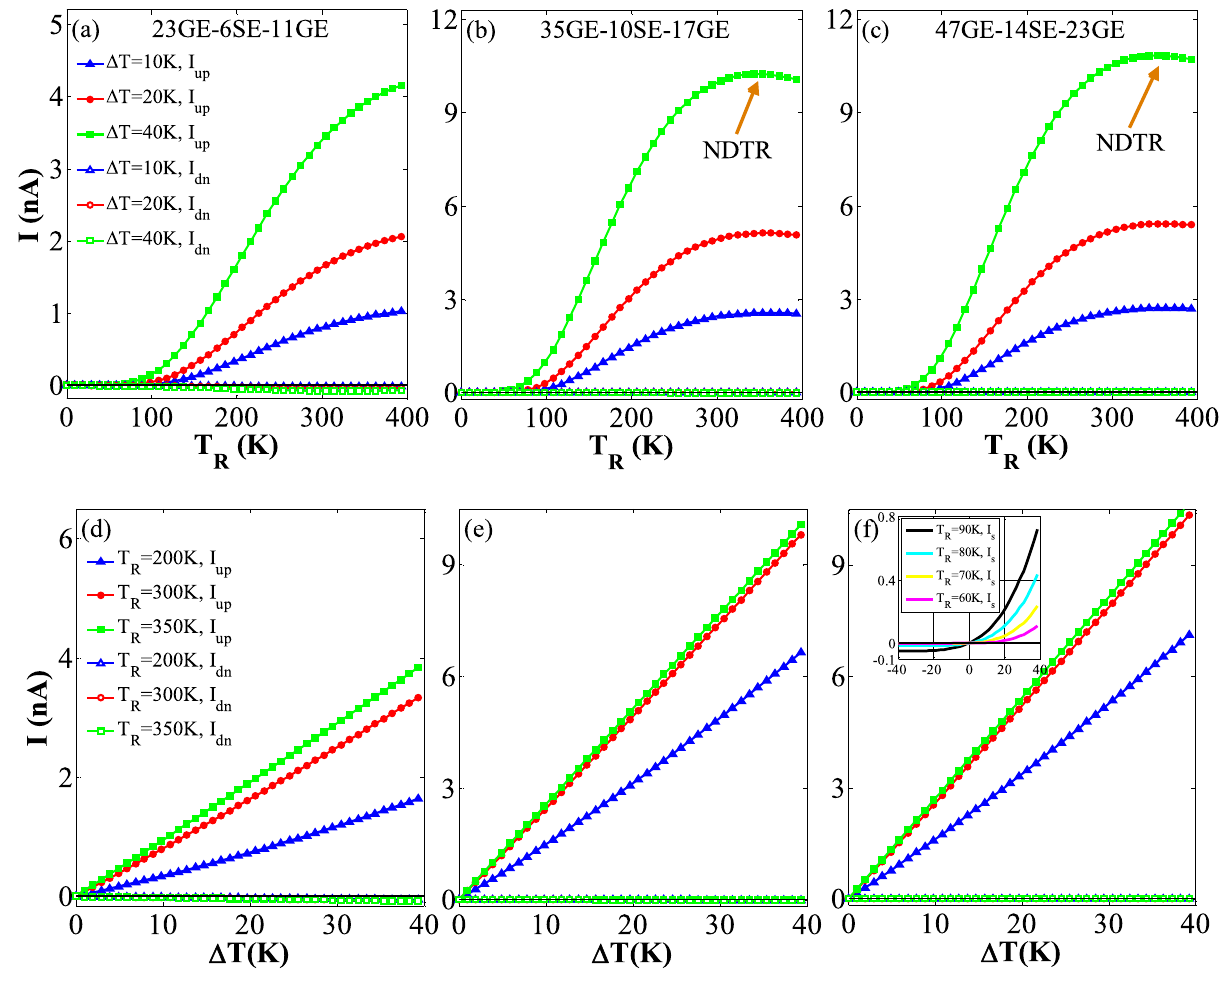
23GE-6SE-11GE, 35GE-10SE-17GE, and 47GE-14SE-23GE configurations,